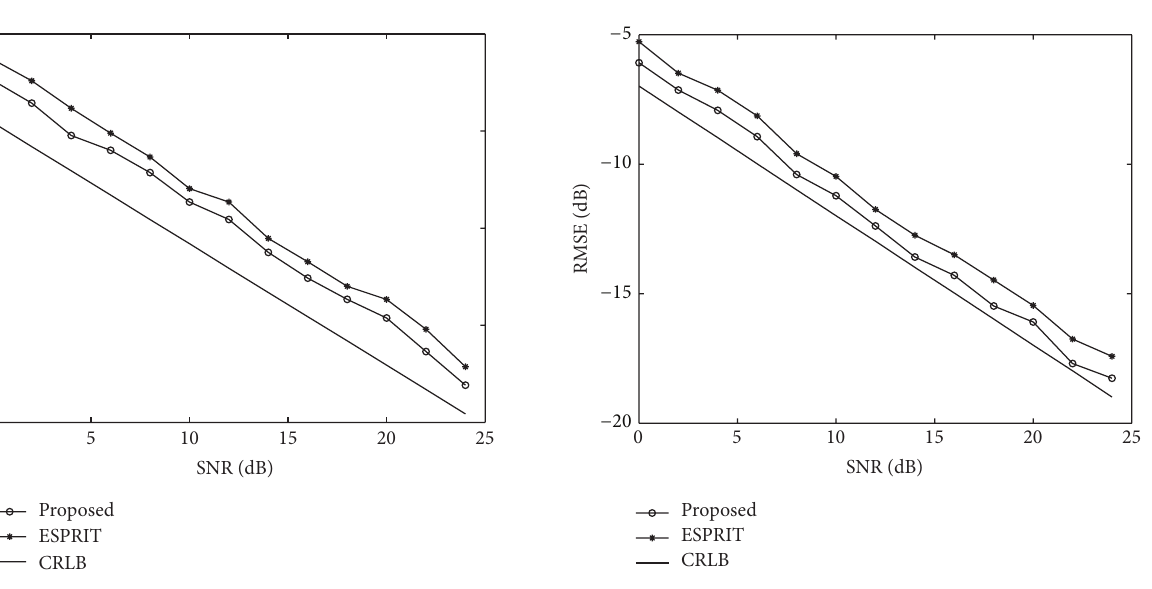
Figure 2: Root mean square error for 𝜙 1 versus SNR. Figure 3: Root mean square error for 𝜃 1 versus SNR.